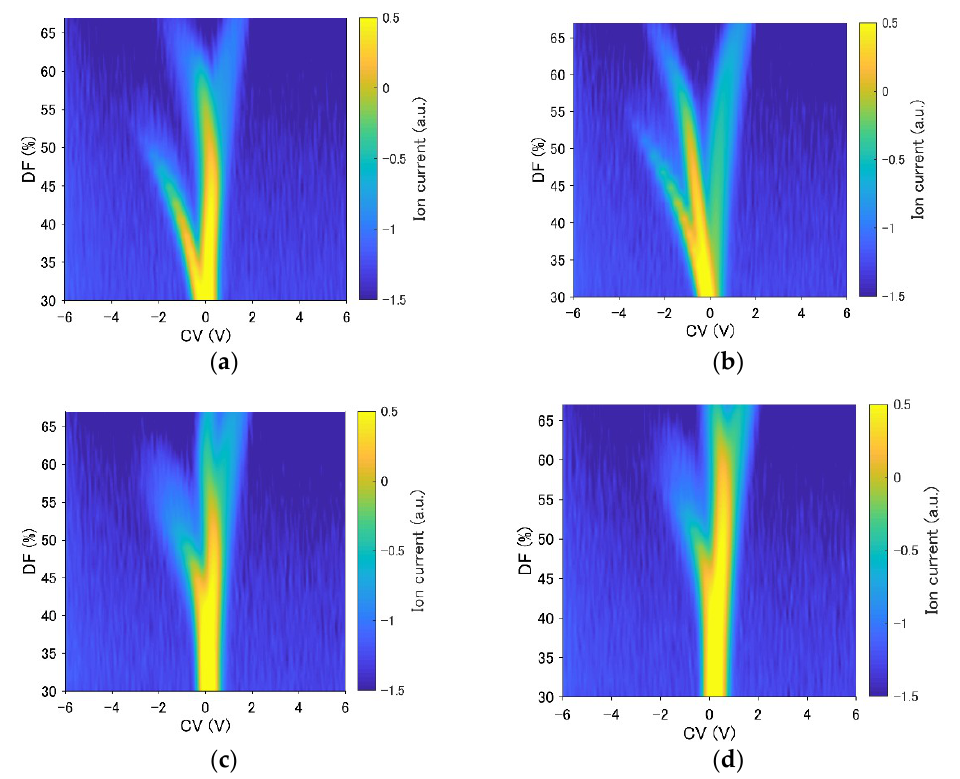
Figure 6. Part of the measurement results of pure gases and a ternary gas mixture. ( a ) Pure diethyl ether (6.1 ppm). ( b ) Pure ethanol (6.1 ppm). ( c ) Pure acetone (4.6 ppm). ( d ) The ternary mixture of acetone (4.6 ppm), ethanol (6.1 ppm), and diethyl ether (6.1